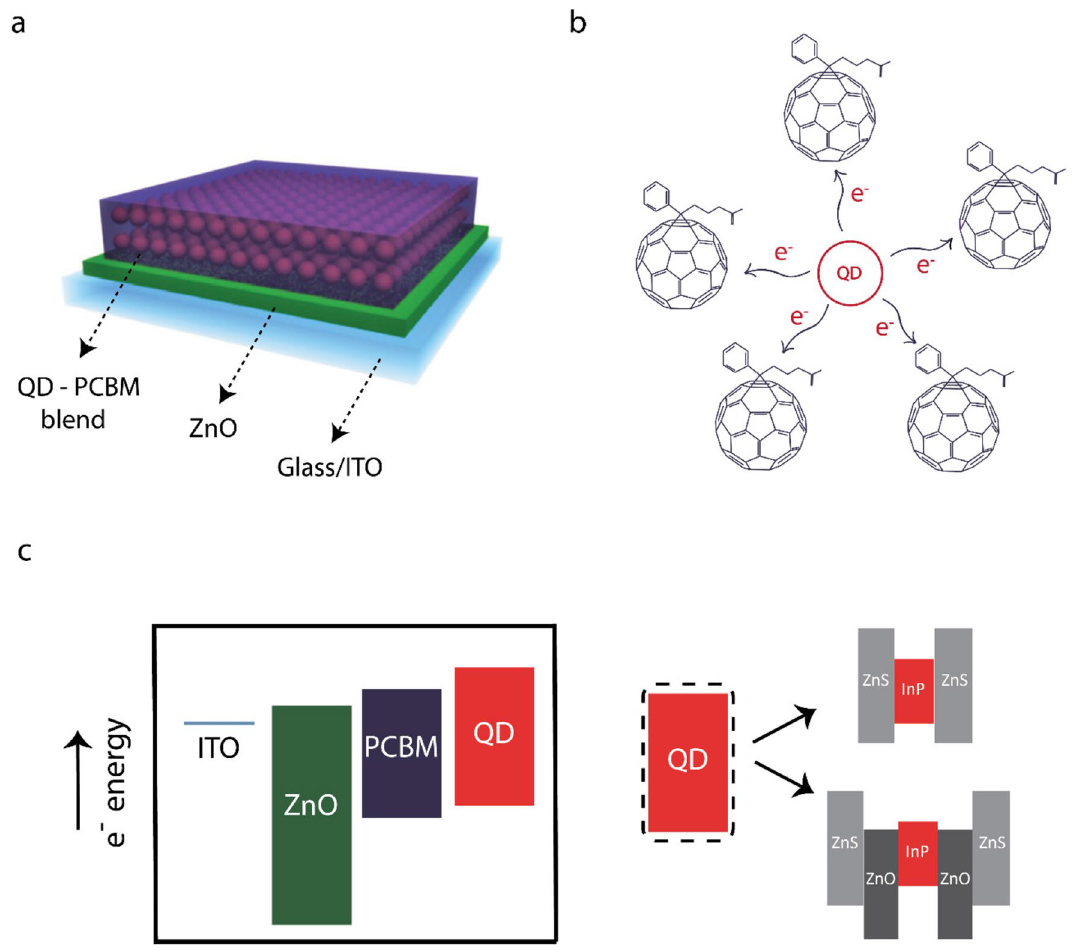
Figure 1. ( a ) The schematic of the quantum dot and PCBM nano-heterojunction device structure, and ( b ) the electron transfer from the InP-based quantum dots to PCBM. ( c ) The energy band alignment based on our previous reports 20,21 . InP/ZnS core/shell and InP/ZnO/ZnS core/shell/shell QDs were incorporated into the photoelectrode